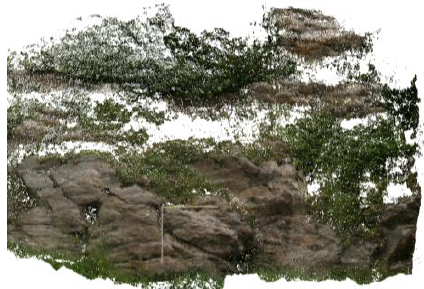
Figure 3. Dense point cloud for Canon5D, computed with MicMac. Vegetated areas show distinct holes.